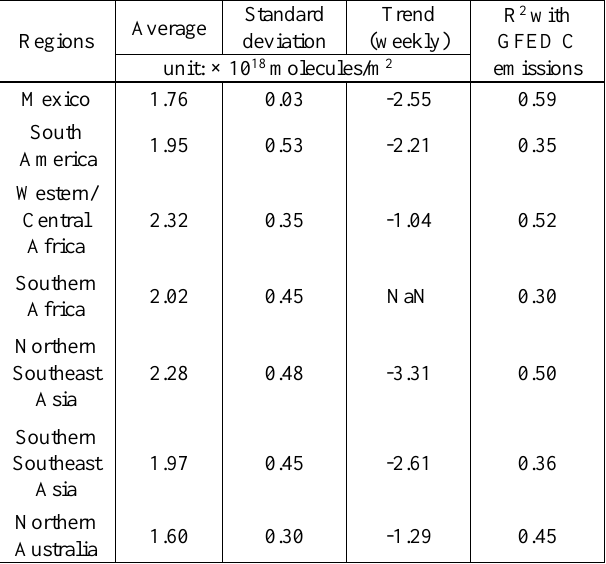
Table 1 . Statistics of MOPITT CO total column